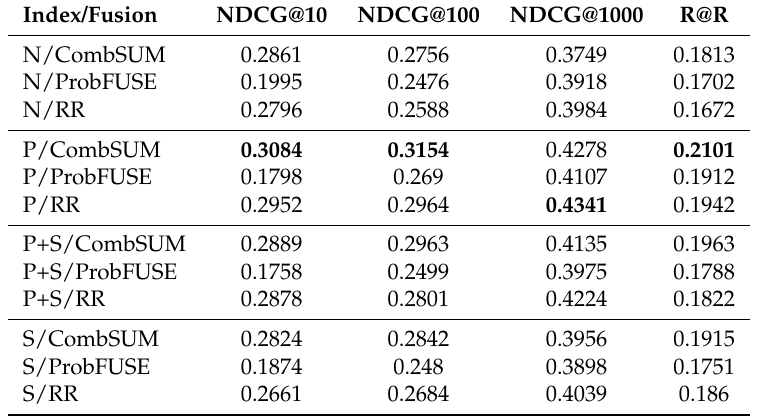
Table 12. T1: NDCG and Recall@R for the fusion runs with QE+RF. The highest values are in bold.